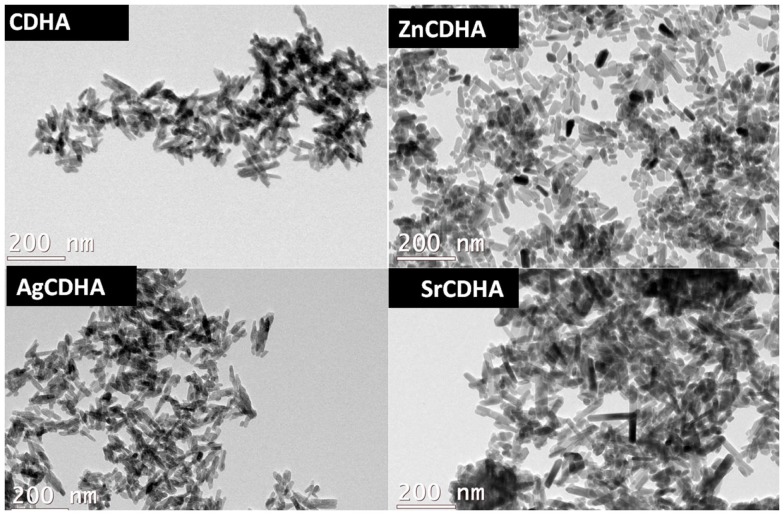
Typical TEM images of CDHA and ion substituted CDHAs.